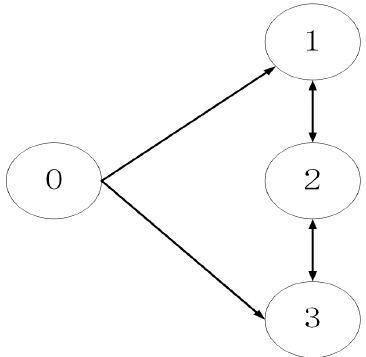
Figure 3. The communication